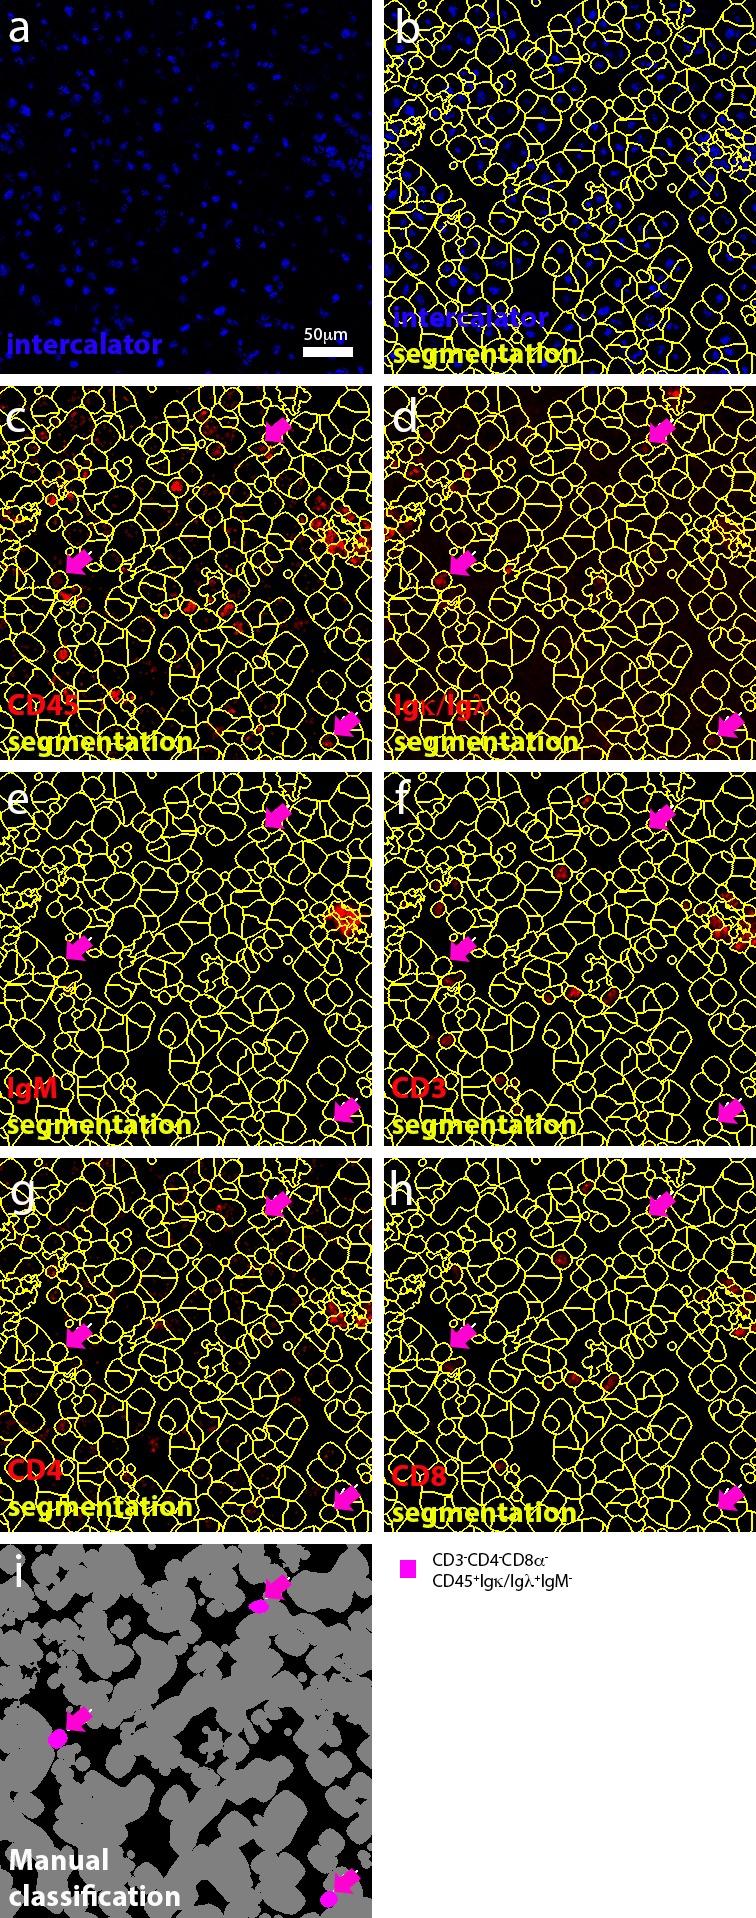
Manual selection of B cells.(a) Representation of manually-annotated cells in a mixed active-inactive lesion, based on the detection of nuclei. (b) Segmented cells. (c–h) Identification of cells that express (for example CD45+Igκ/Igλ+) or do not express (for example CD3-CD4-CD8-) a biologically relevant set of markers. (i) Classification of B cells. Magenta arrows were used throughout c–i) to track B cells.